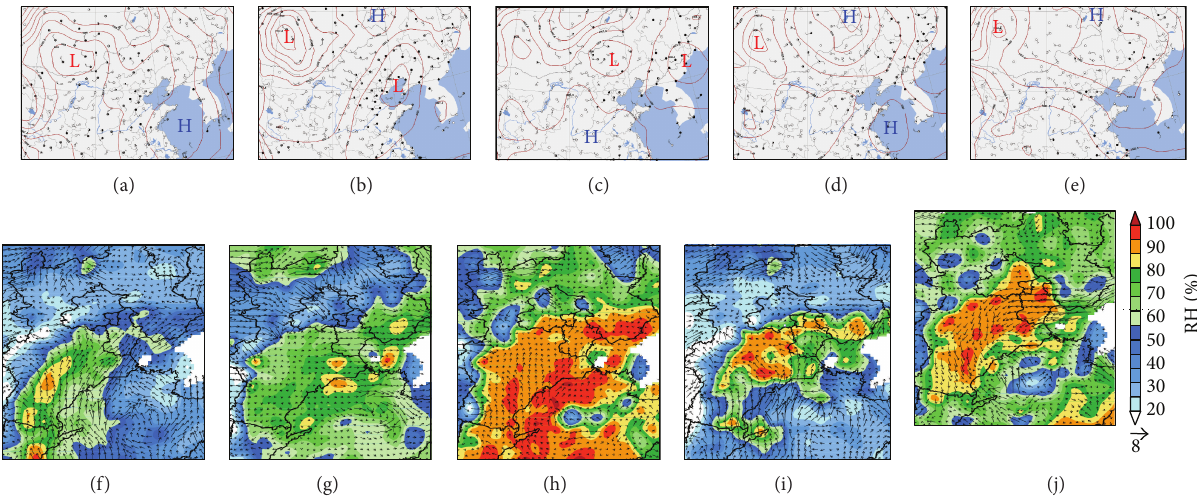
Figure 10: Synoptic maps at (a) 14:00 LST 10 January, (b) 14:00 LST 11 January, (c) 02:00 LST 12 January, (d) 14:00 LST 12 January, and (e) 02:00 LST 13 January; wind fields and humidity fields (shadings) at (f) 14:00 LST 10 January, (g) 17:00 LST 11 January, (h) 08:00 LST 12 January, (i) 14:00 LST 12 January, and (j) 02:00 LST 13